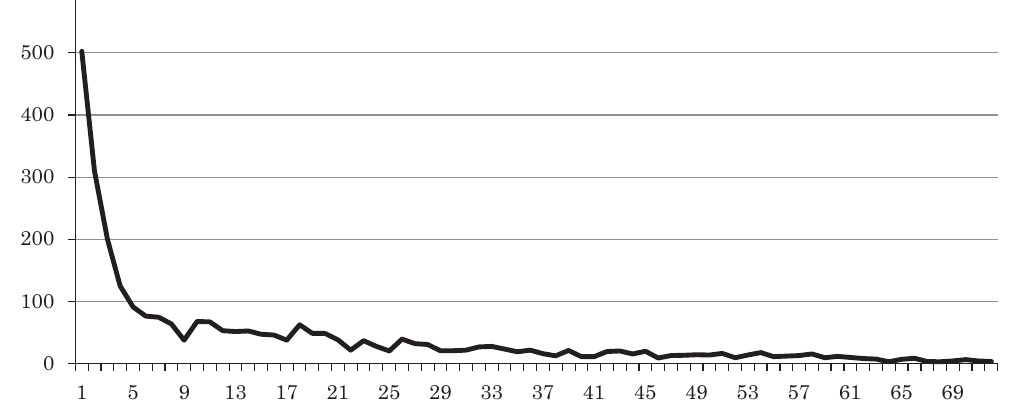
Figure 1. Number of transactions per